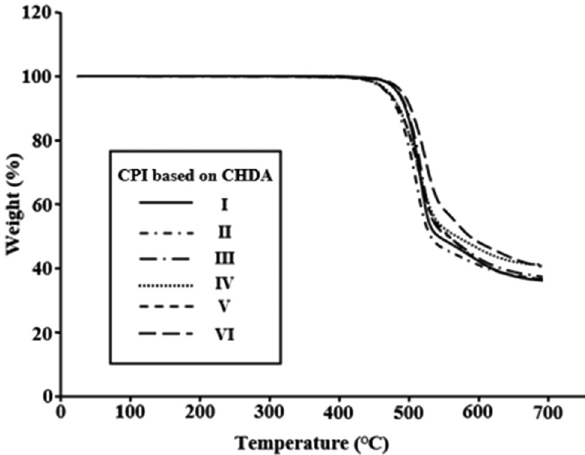
Figure 6: TGA thermograms of the CPI fi lms obtained from the CHDA monomer.